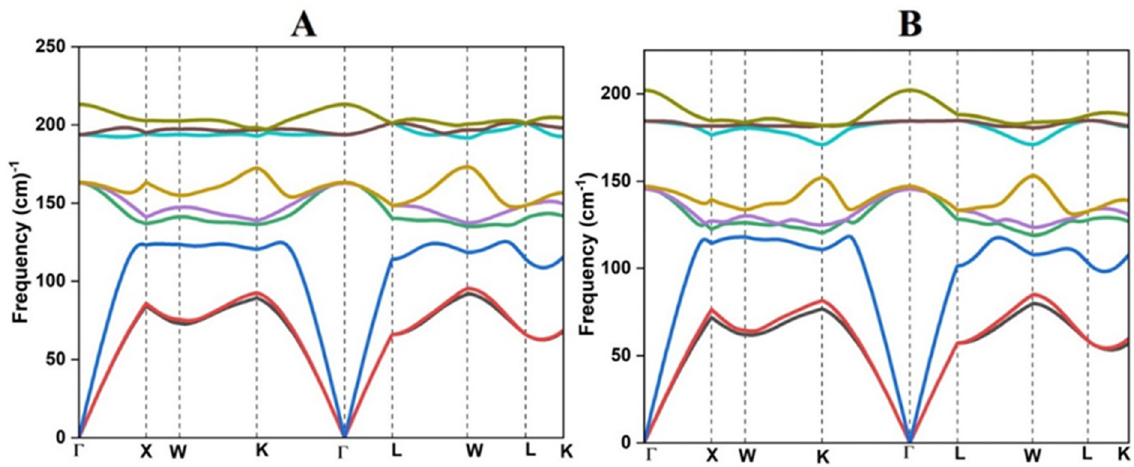
Figure 2. Phonon dispersion curve of ( A ) PdZrSn and ( B ) PdHfSn half Heusler materials.